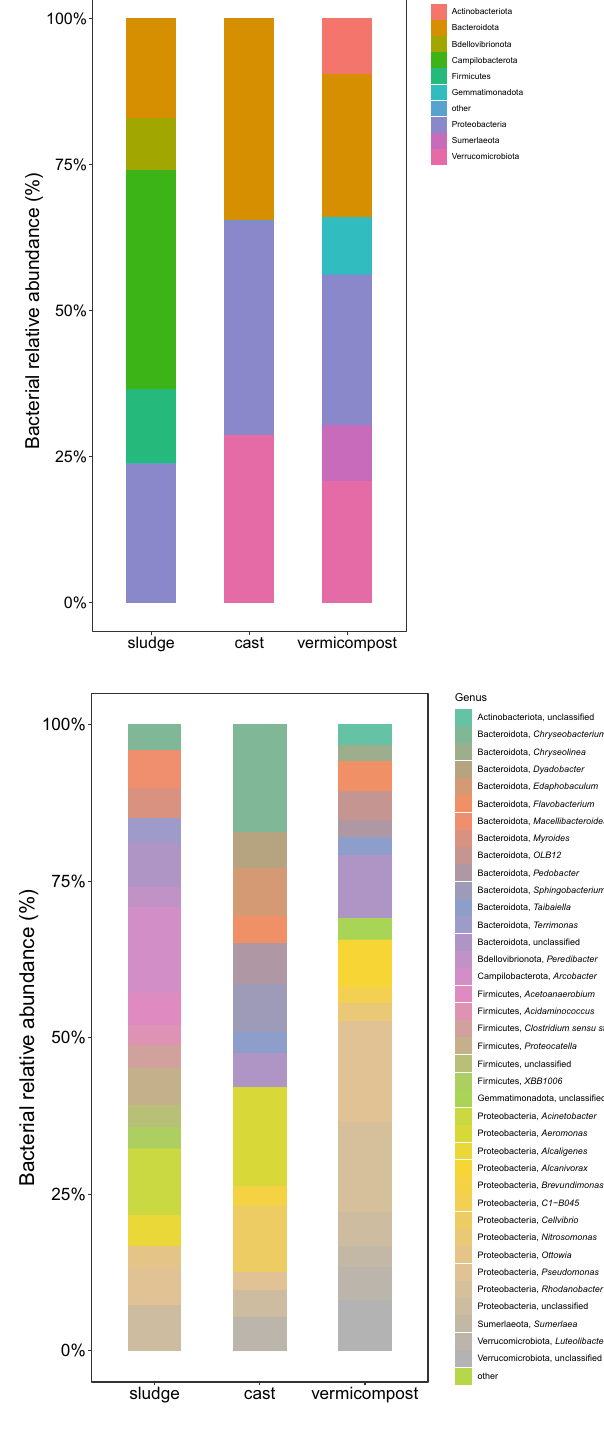
Figure 1. Relative abundance of the main phyla and genera of bacteria in sewage sludge, fresh earthworm casts and vermicompost (3 months old) during vermicomposting of sewage sludge. Low abundance bacterial phyla and genera (< 1%) were grouped together